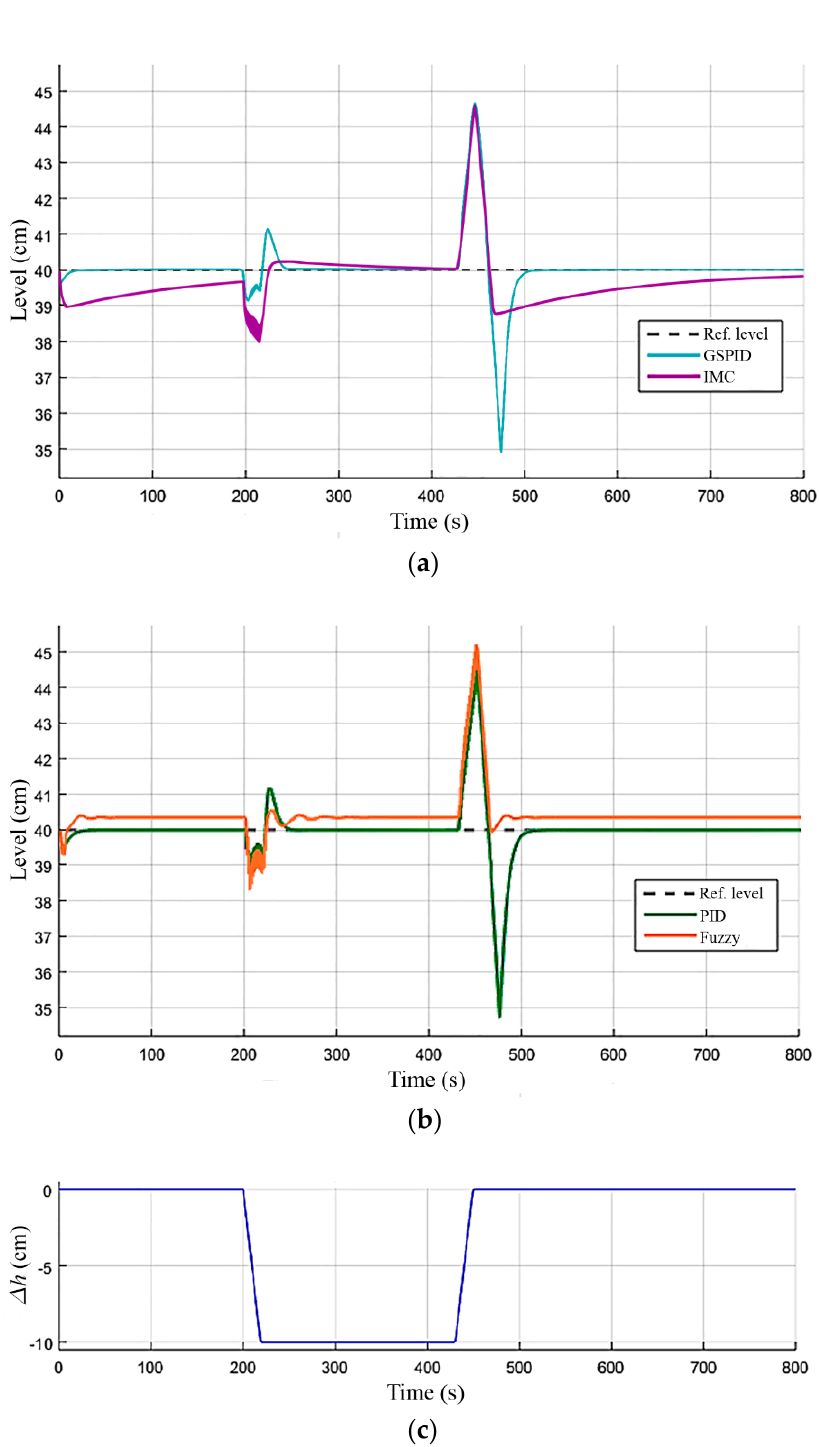
Figure 12. Controllers’ response to a load disturbance at the tank level: ( a ) GSPID and IMC controllers, ( b ) PID and Fuzzy controllers; ( c ) Level change ( ∆ h ) as a result of the load disturbance.